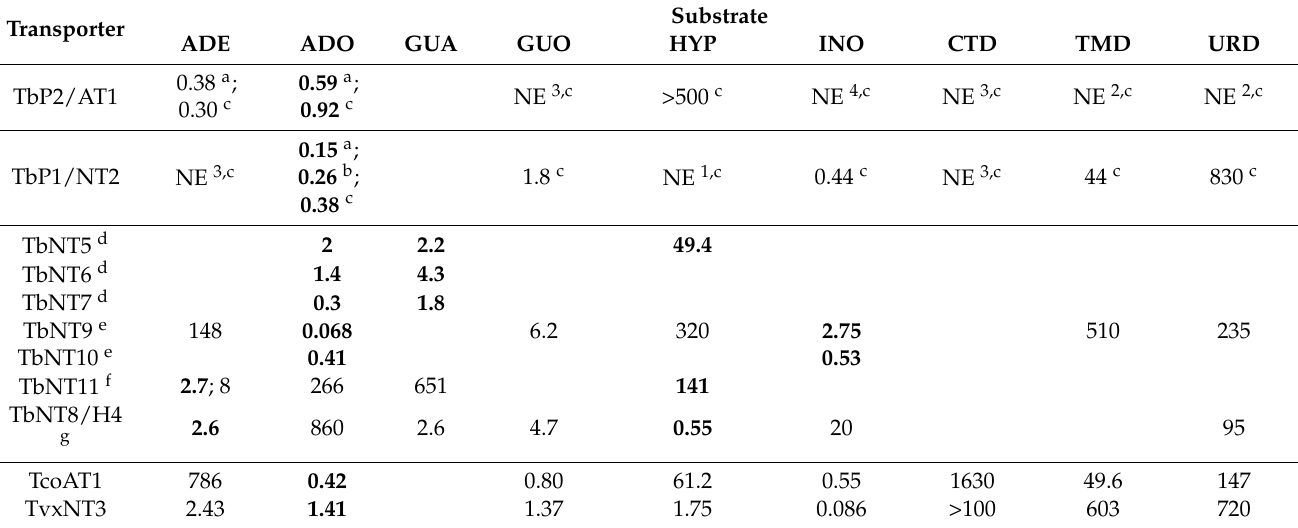
Table 10. Kinetic parameters of nucleoside transporters of T. brucei brucei, T. congolense and T. vivax . Transporter